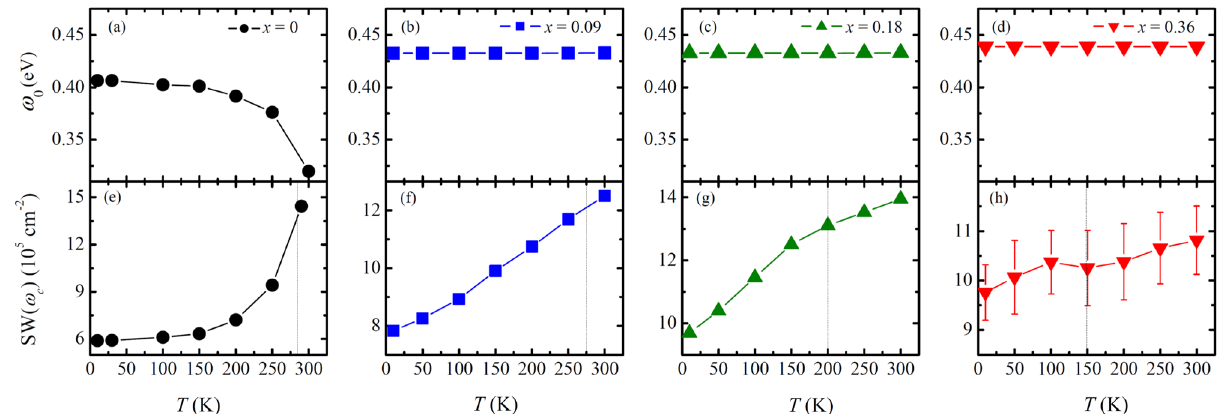
Figure 4. Temperature dependence of the peak α of Sr 3 (Ir 1− x Mn x ) 2 O 7 with ( a ) x = 0, ( b ) x = 0.09, ( c ) x = 0.18, ( d ) x = 0.36. Temperature dependence of the SW( ω c ) for ( e ) x = 0 ( ω c = 0.34 eV), ( f ) x = 0.09 ( ω c = 0.34 eV), ( g ) x = 0.18 ( ω c = 0.36 eV) and ( h ) x = 0.36 ( ω c = 0.33 eV). The dashed lines in ( e )–( h ) denote the Néel temperature for each